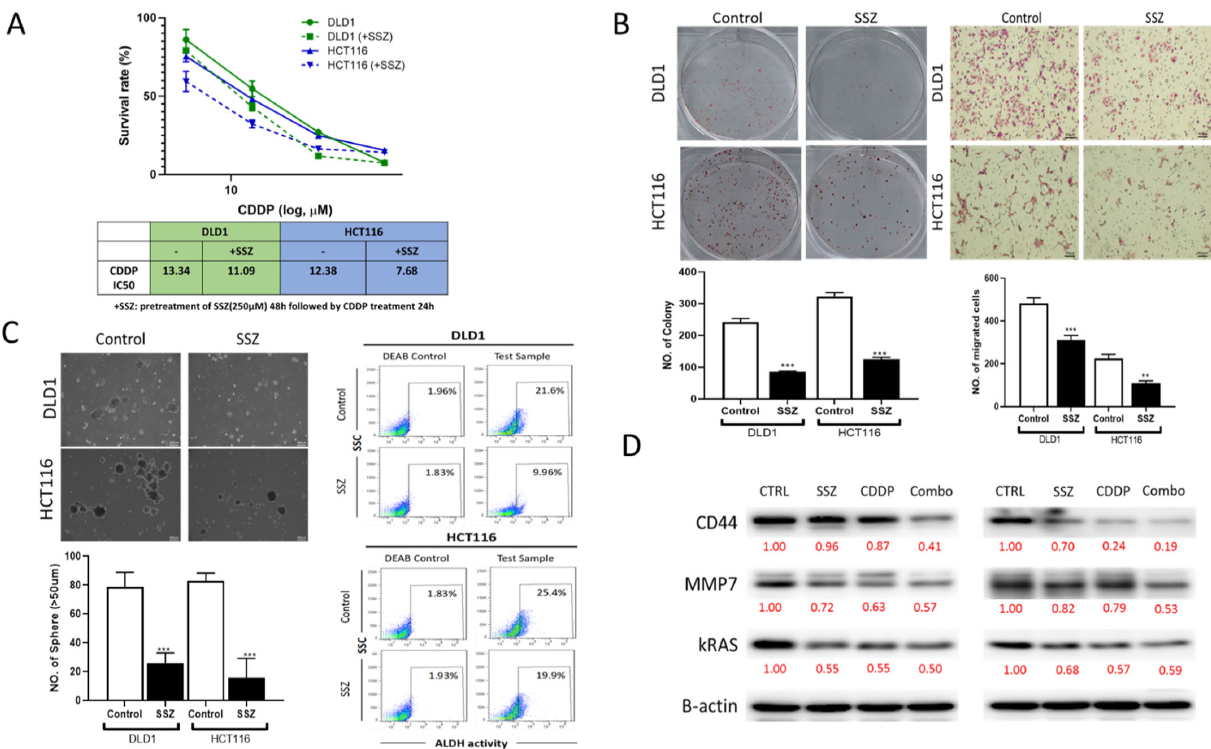
Figure 11. Sulfasalazine (SSZ) treatment reduced tumorigenic properties of CRC cells and enhanced cisplatin (CDDP) efficacy. ( A ) SSZ enhanced cisplatin efficacy in both DLD ‐ 1 and HCT116 cell lines. IC50 values are shown. Representative micrographs of the suppressive effects of SSZ on the ability of DLD ‐ 1 and HCT116 cells to form ( B ) colonies, migration ( C ) tumorspheres, and also reduced ALDH activity (cancer stemness marker) of DLD ‐ 1 and HCT116 cells. ( D ) Western blot results showed that SSZ and CDDP combined treatment significantly reduced the expression level of KRAS, MMP7, and CD44 on CRC cells compared to their vehicle ‐ treated counterparts. β ‐ actin served as the loading control. * p < 0.05, ** p < 0.01, *** p < 0.001. Numbers in red represent the relative expression level of the band intensity estimated using ImageJ software.